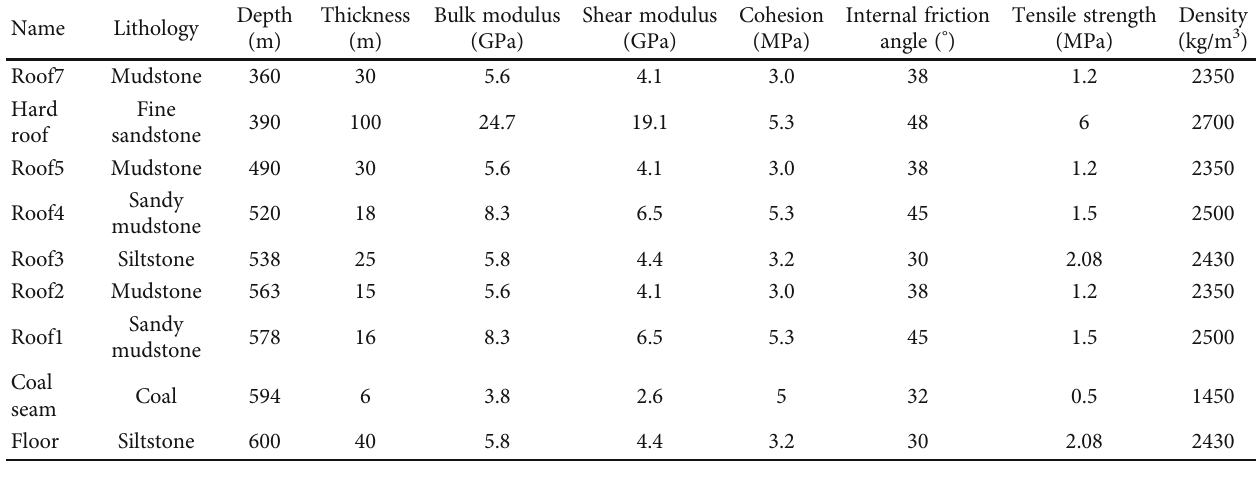
Figure 7: The numerical simulation model. Table 2: Rock mass physical and mechanical